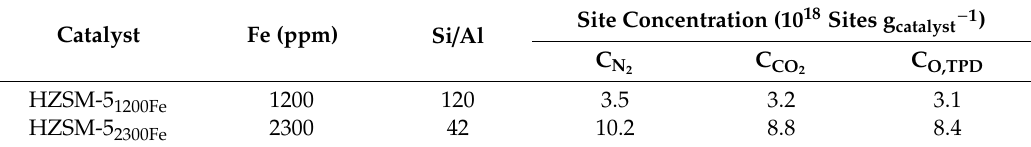
Table 1. Characteristics of HZSM-5 catalysts after thermal treatment in He at 1273 K for 1 h.